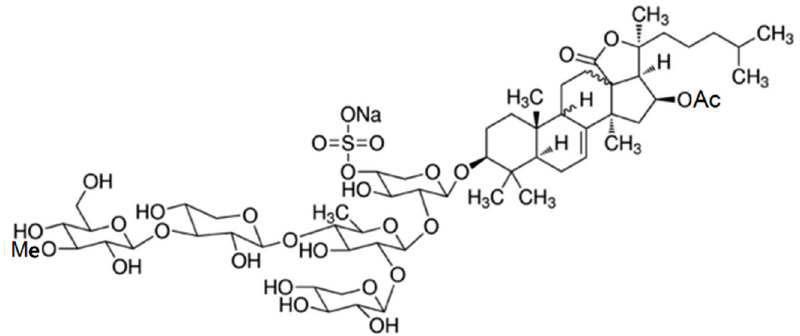
Figure 19. Frondoside A ( 85 ) isolated from sea cucumber Cucumaria frondosa